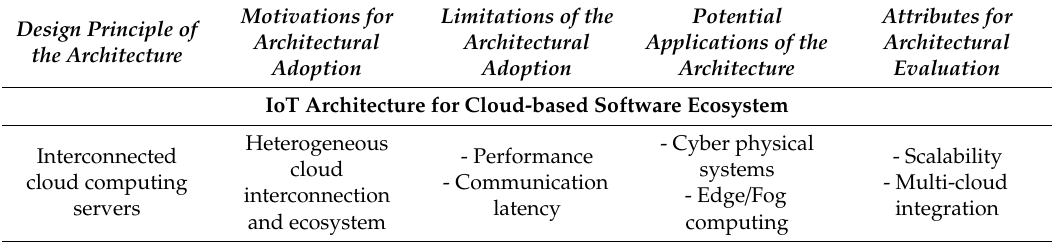
Table 12. Criteria-based assessment of the existing software architectures for IoT